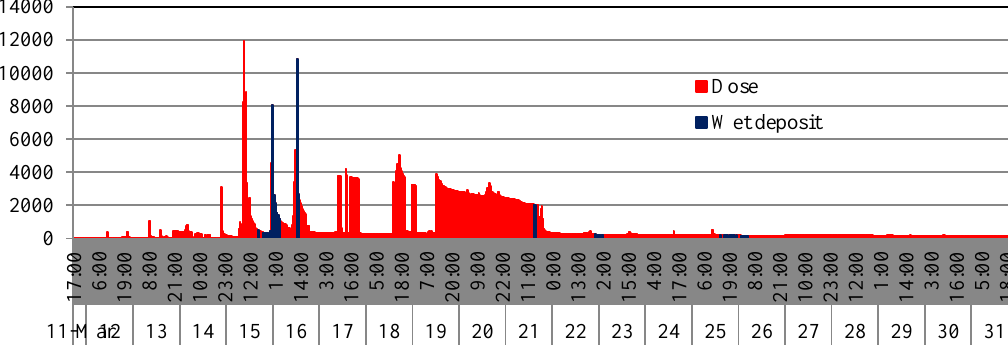
Figure 7. A time series of spatial dose (unit: μ Sv/h) and the ratio of dry and wet deposits.